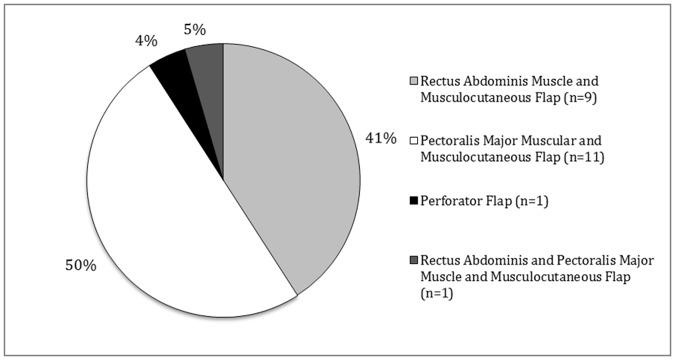
Muscle Flaps used in DSWI.